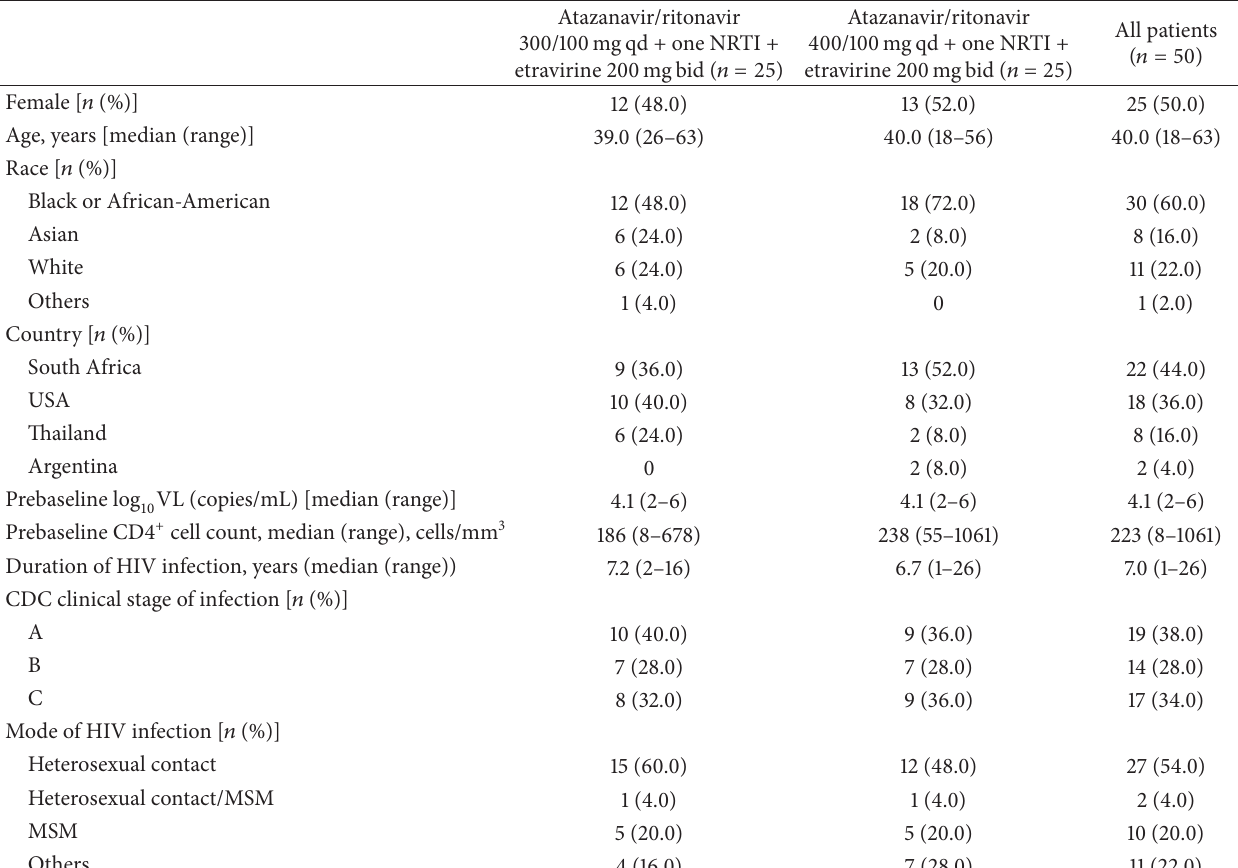
Table 1: Patient baseline demographics and disease characteristics of patients who started the pretreatment session.